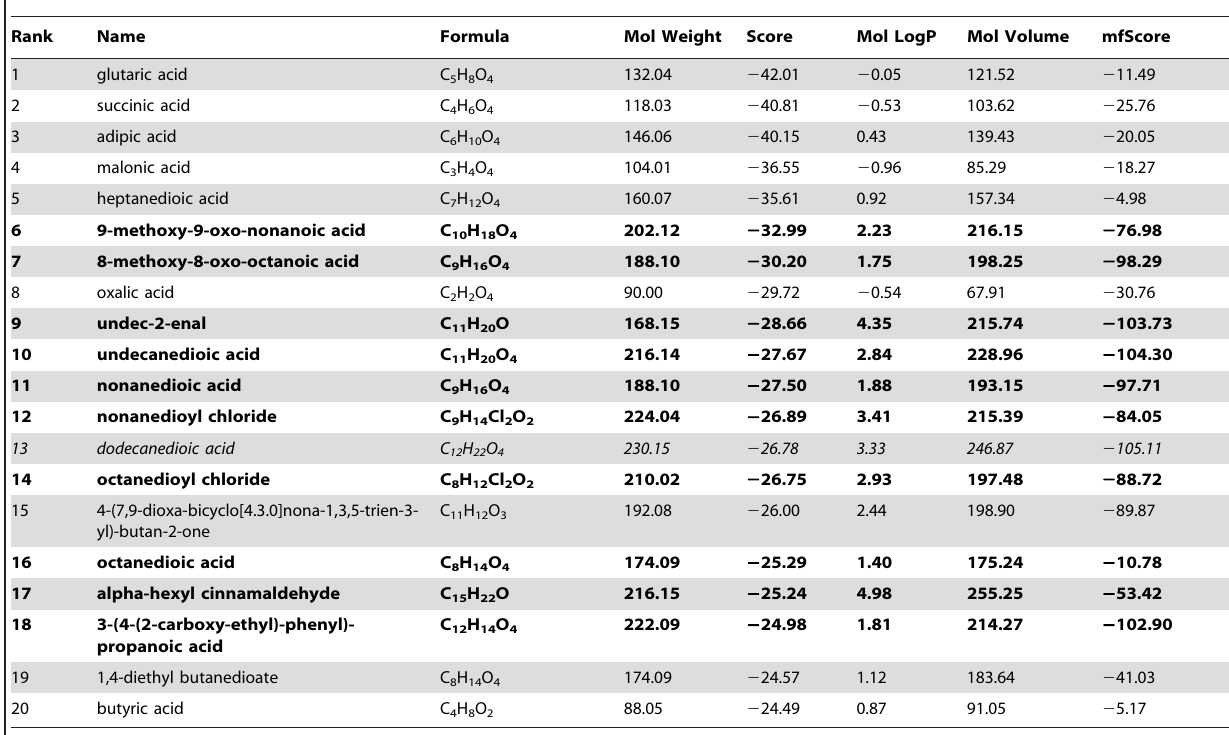
Table 1. Properties of the top 20 candidates as ranked by VLS